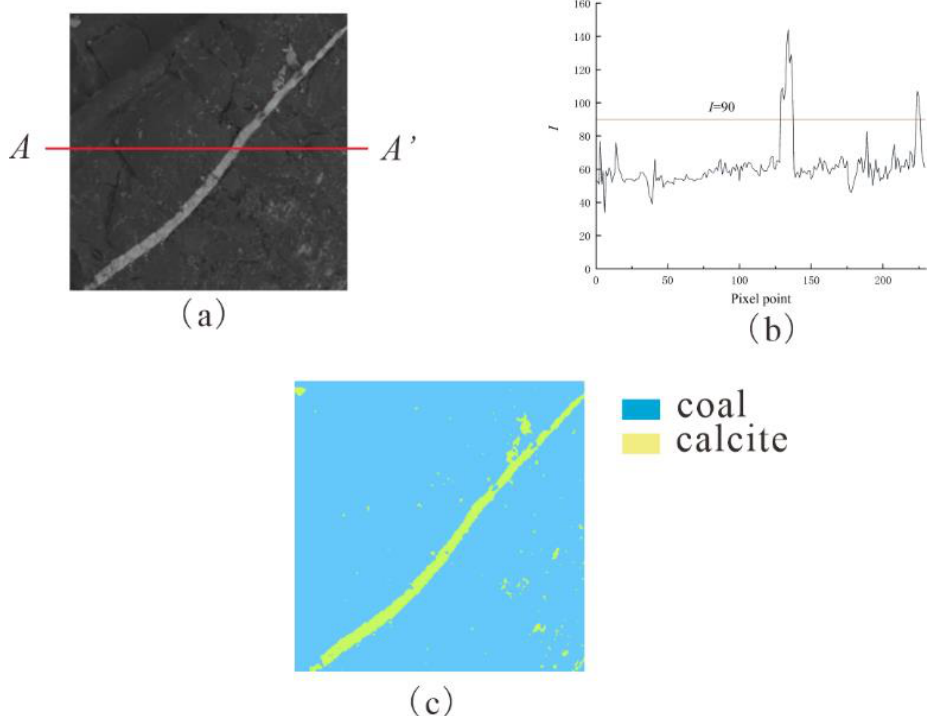
Figure 1. Calcite vein filled coal. ( a ) Surface image of coal; ( b ) change curve of I value on scan line AA ’; ( c ) image after threshold segmentation.